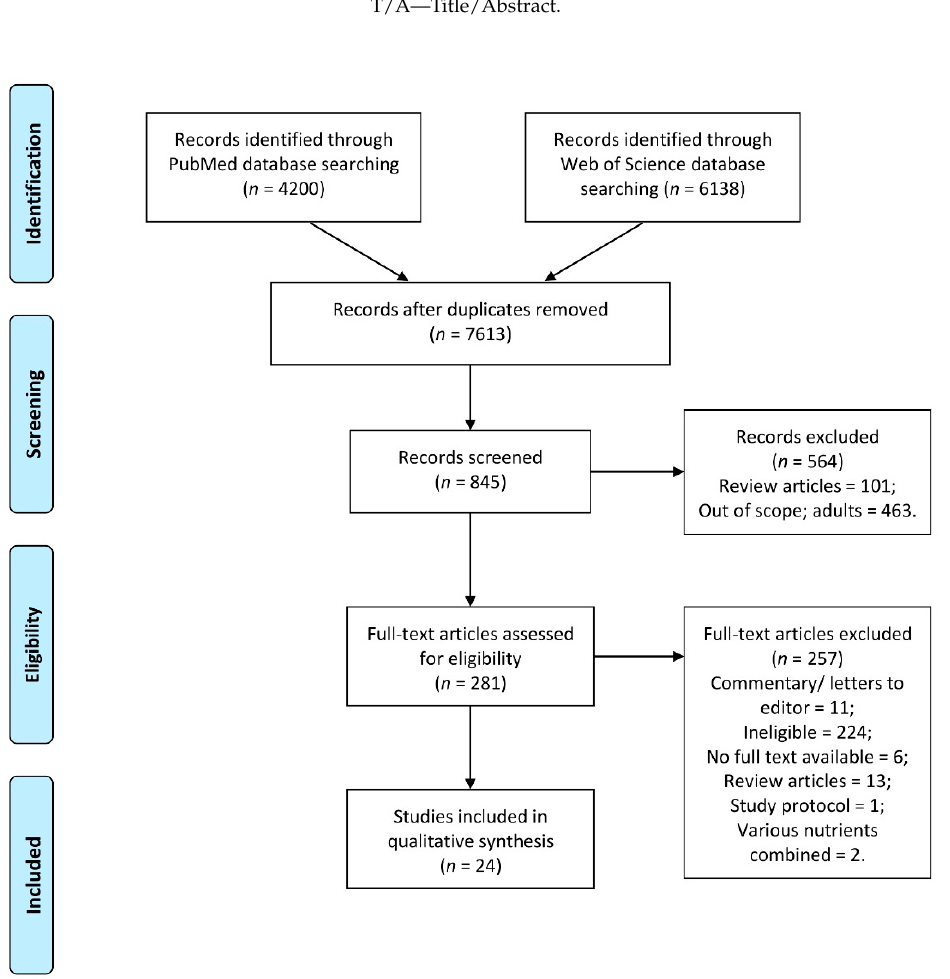
Figure 1. The detailed inclusion procedure in a systematic review of the